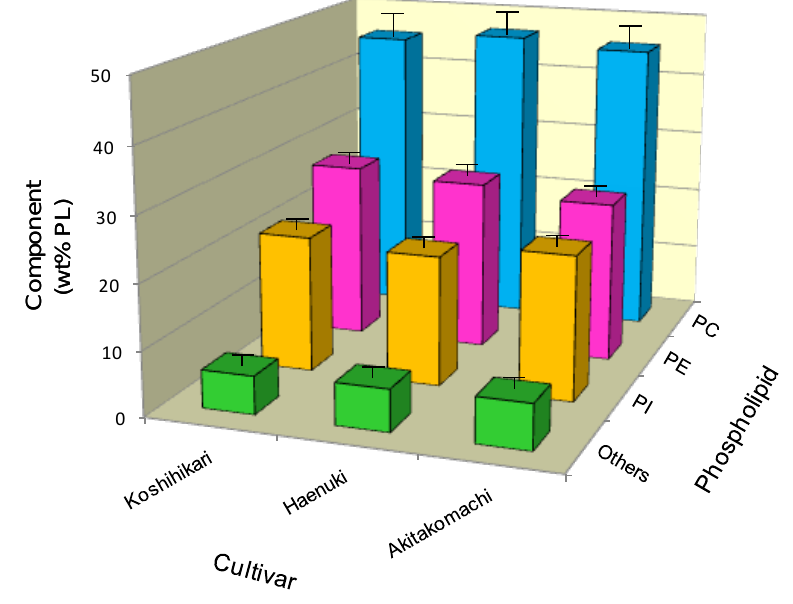
Figure 2. PL components in the oils prepared from rice brans. Each value represents the average of three determinations, and vertical bars depict the mean and standard